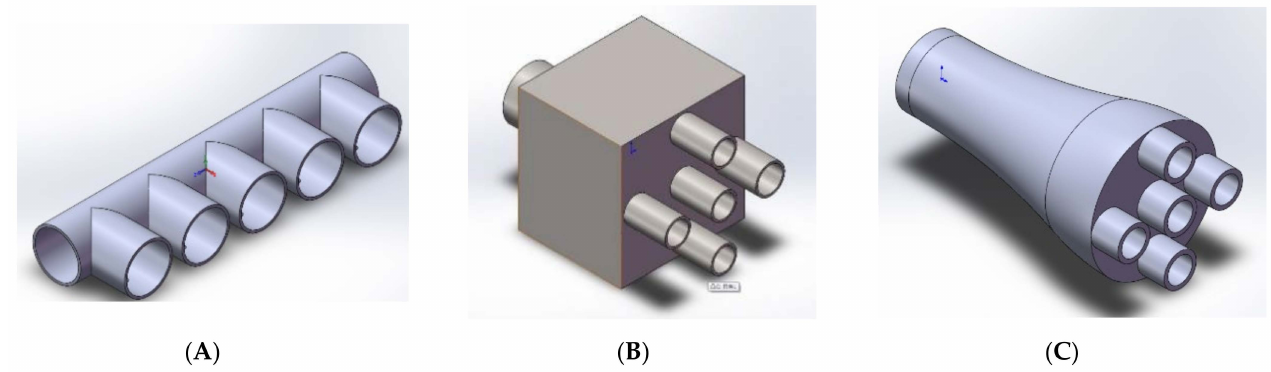
Figure 10. Different types of airflow distributor. ( A ) Linear type; ( B ) Box type; ( C ) Arc transition type.